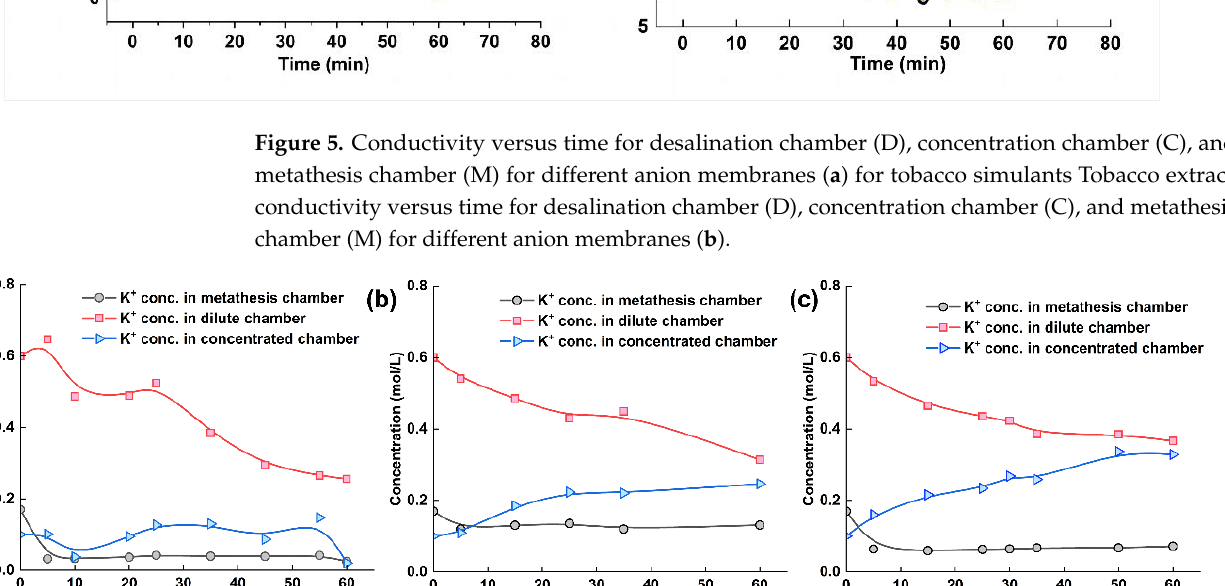
Figure 5. Conductivity versus time for desalination chamber (D), concentration chamber (C), and metathesis chamber (M) for different anion membranes ( a ) for tobacco simulants Tobacco extract; conductivity versus time for desalination chamber (D), concentration chamber (C), and metathesis chamber (M) for different anion membranes ( b ).